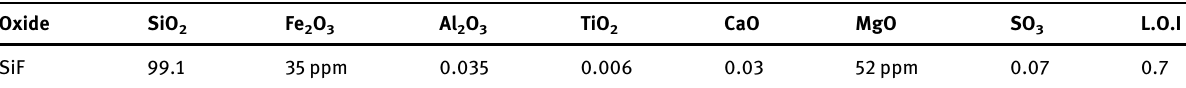
Table 3: Chemical composition of SiF